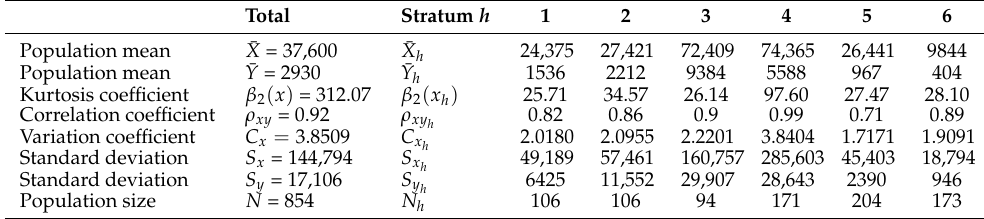
Table 2. Population 2 summaries.